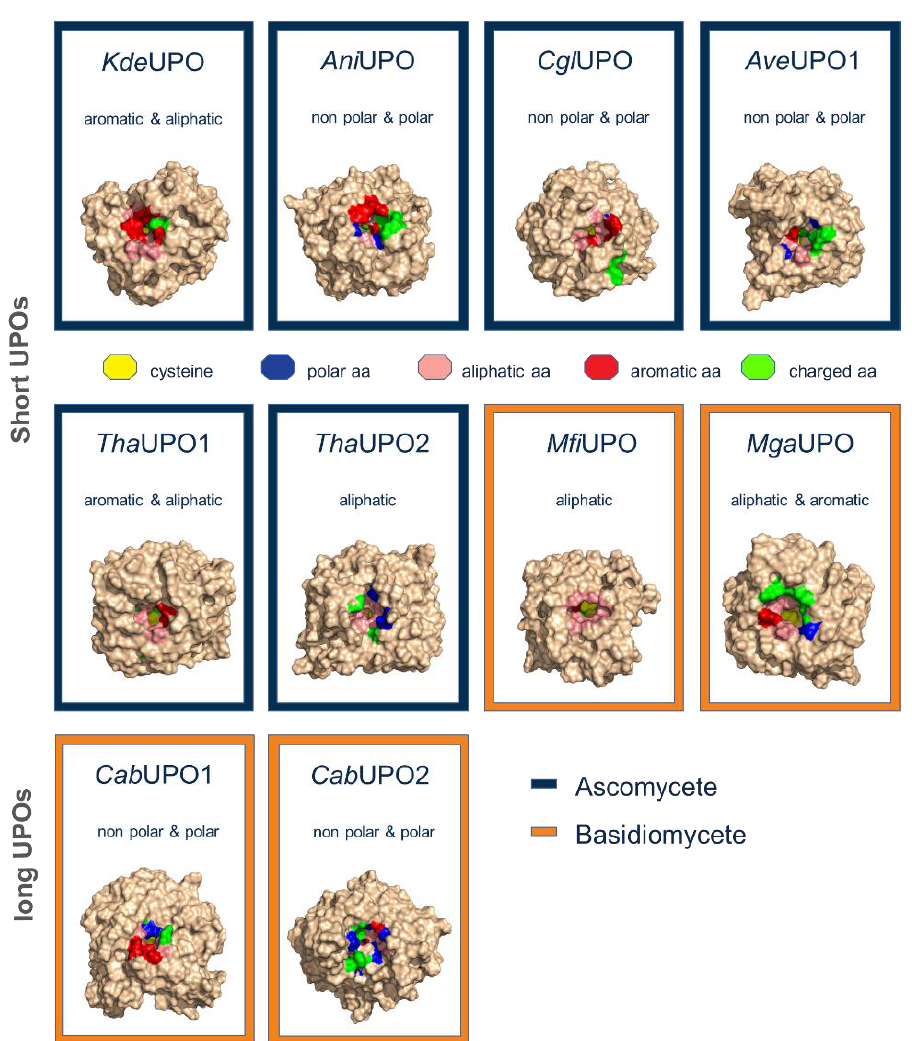
Figure 2. Homology modeled UPO candidates for recombinant